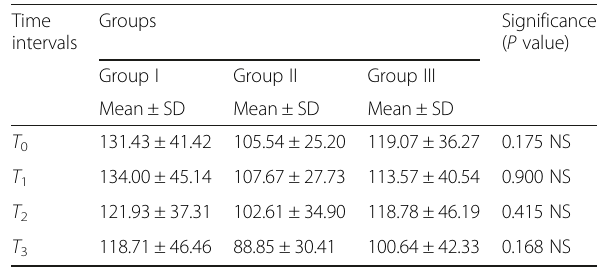
Table 5 Between the group comparisons of DIAGNOdent scores at various time intervals of